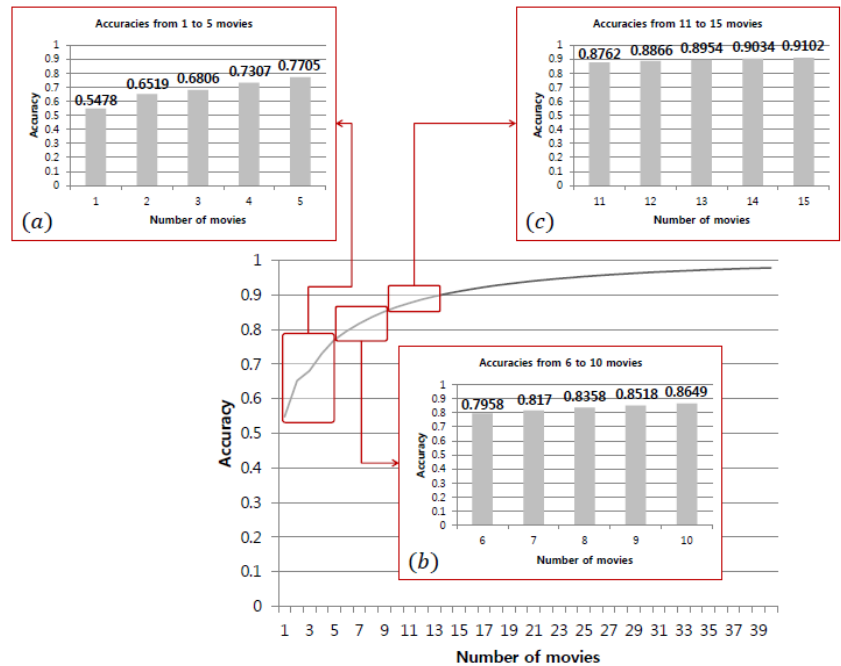
Figure 33. Accuracy of different random sample sizes. Table 14. Accuracy change and average difference for each range.